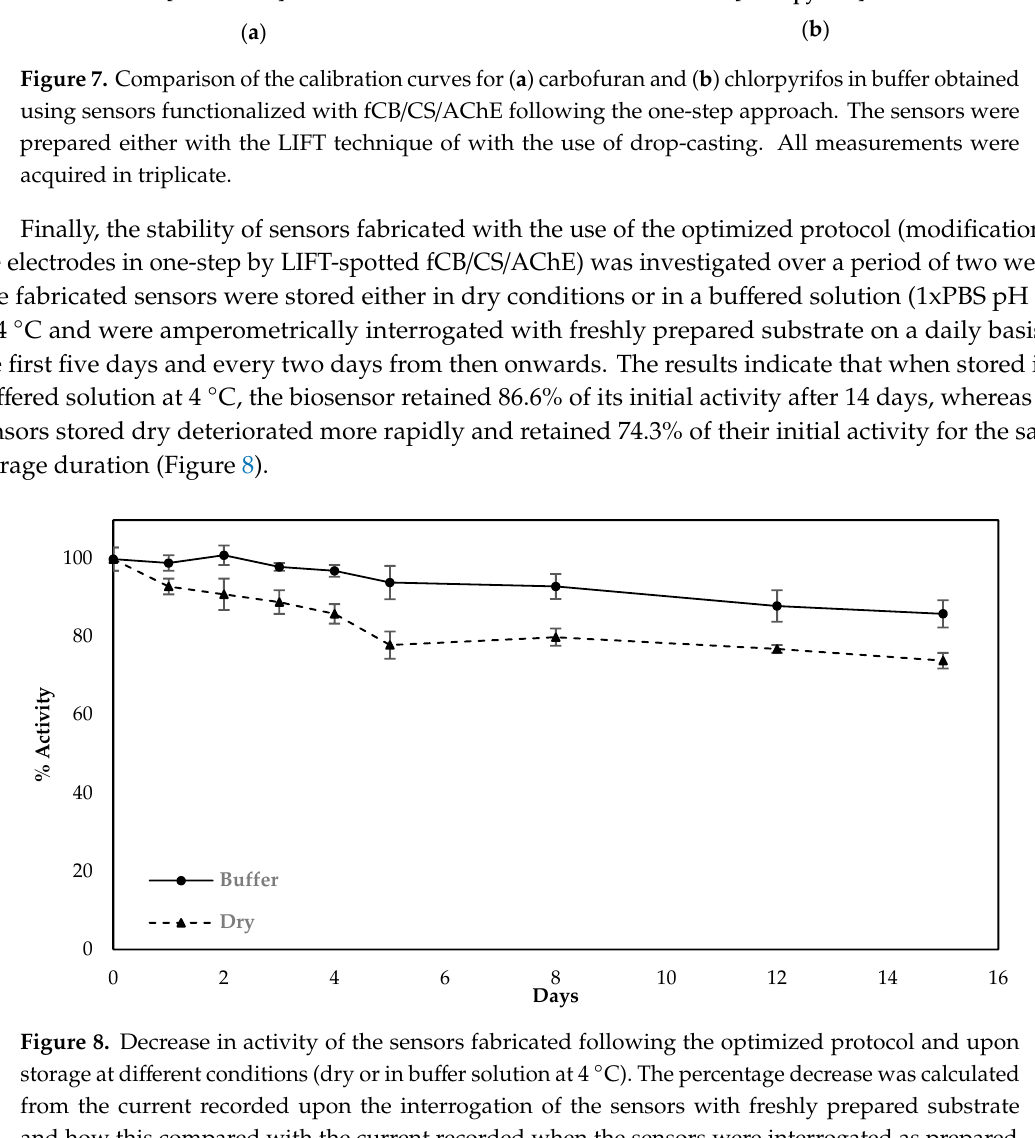
Figure 7. Comparison of the calibration curves for ( a ) carbofuran and ( b ) chlorpyrifos in buffer